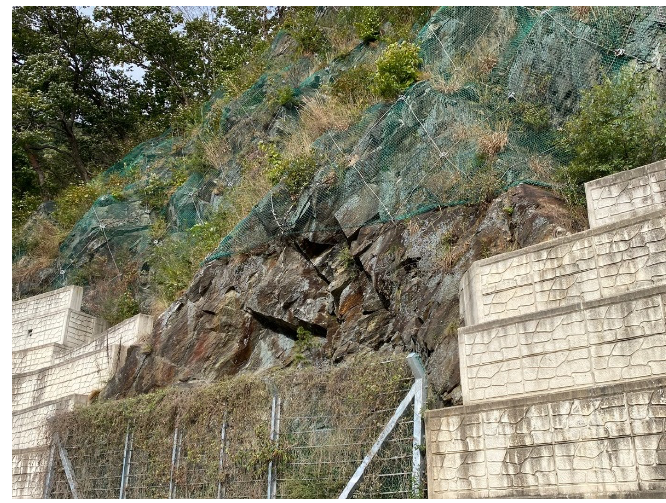
Figure 8. Complex GGSJ (concrete, gabion, artificial soil).